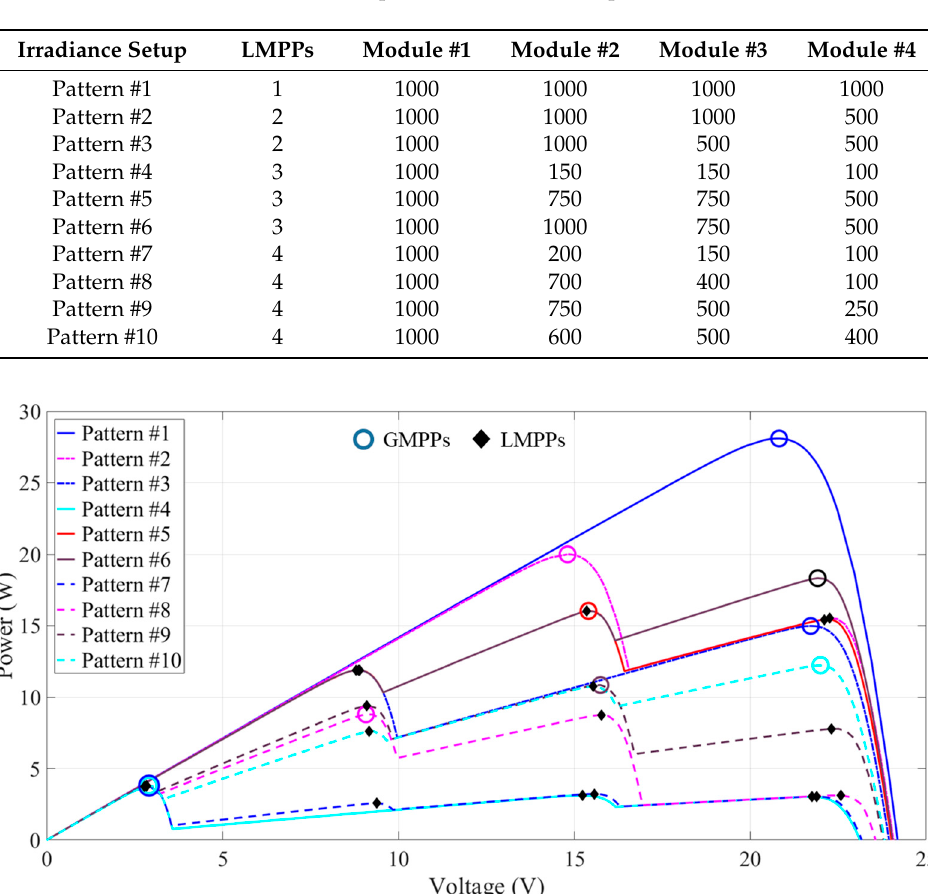
Table 2. Irradiance setups of the 10 evaluation patterns (W/m 2 ).